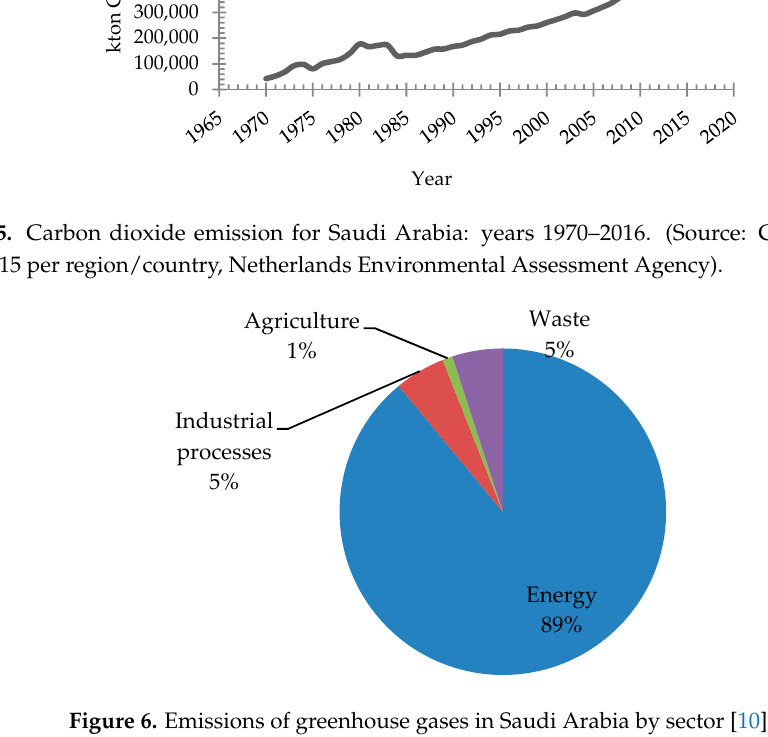
Figure 6. Emissions of greenhouse gases in Saudi Arabia by sector [10].